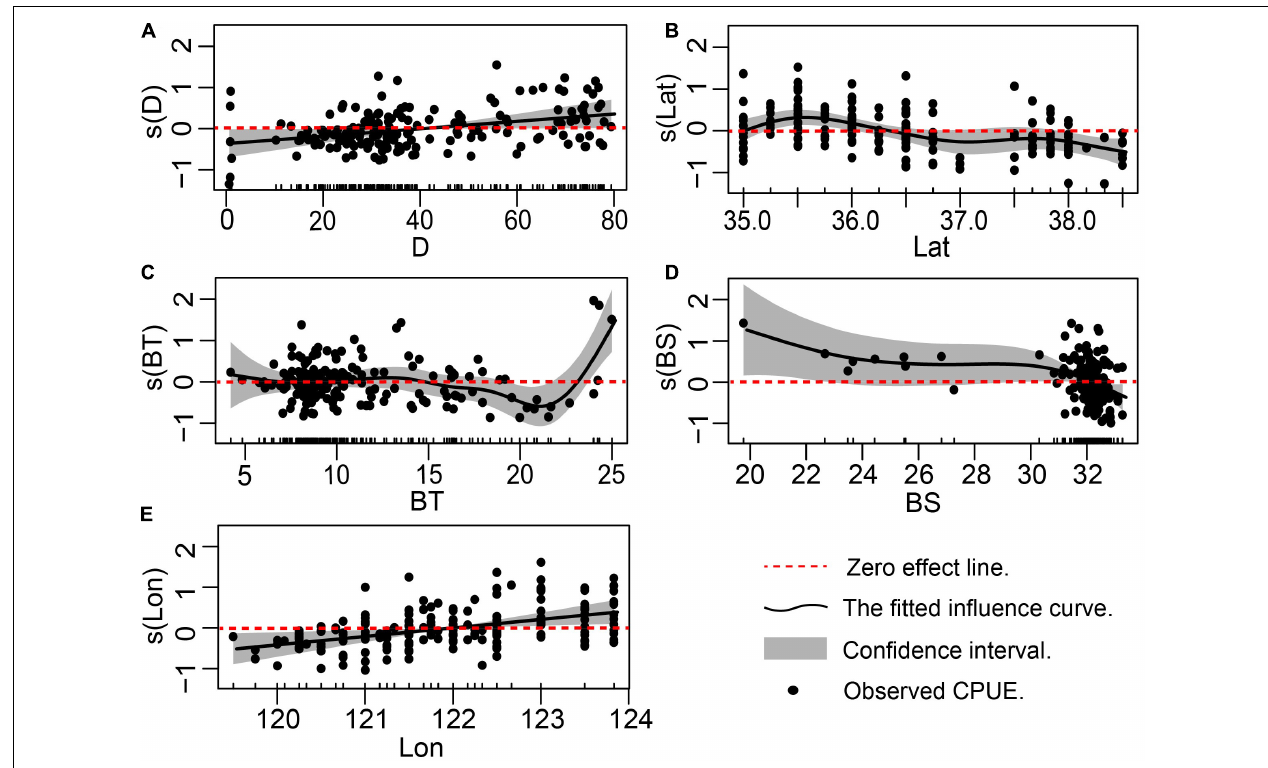
FIGURE 4 | Effects of environmental factors on the CPUE of Lophius litulon in Shandong coastal waters. (A) Depth; (B) Latitude; (C) Bottom temperature; (D) Bottom salinity; (E) Longitude.